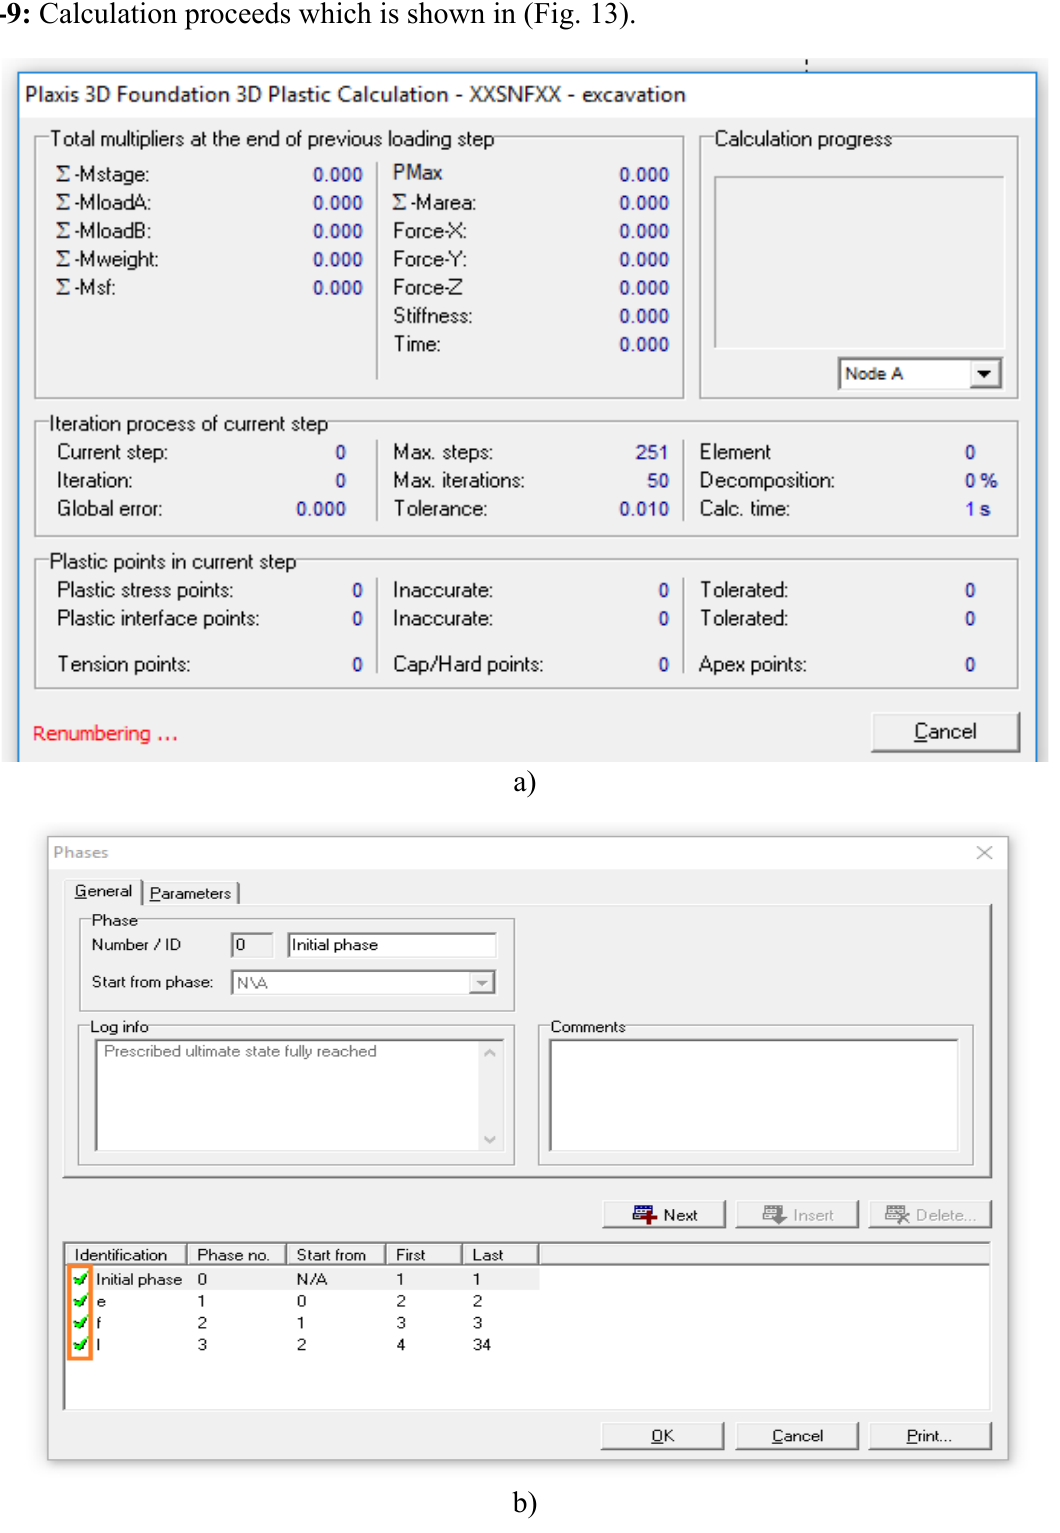
Fig. 13. Calculation phase a) Calculations sheet, b) Confirmation of correct